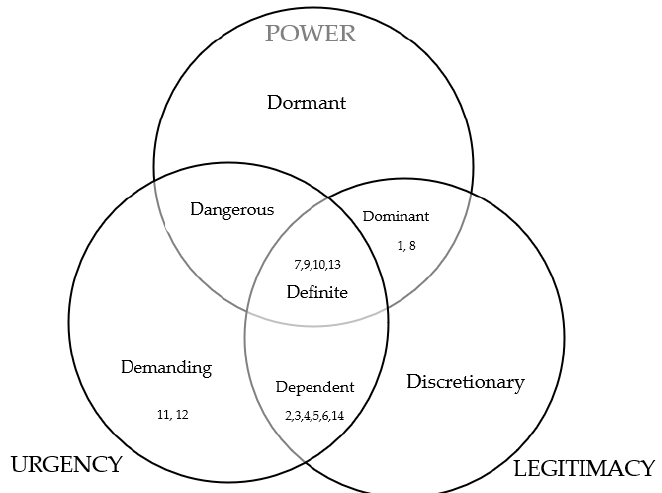
Figure 2. The salience of stakeholders towards GT in Lithuania. Source: elaborated by authors from the research results, following Mitchells et al.’s (1997) methodology [45].